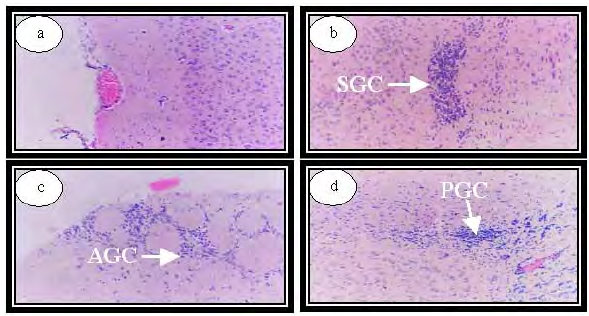
Figure 12 : Histopathology of brain from female rats treated with saline (a) showing normal brain tissue; AcAait (b) showing scatterd glial cells (SGC) within the brain tissue; AcMNPV (c) showing aggregation of glial cells (AGC) between nerve fibers; and SlNPV (d) showing proliferation of glial cells (PGC) in the cerebral cortex (H&E x300).